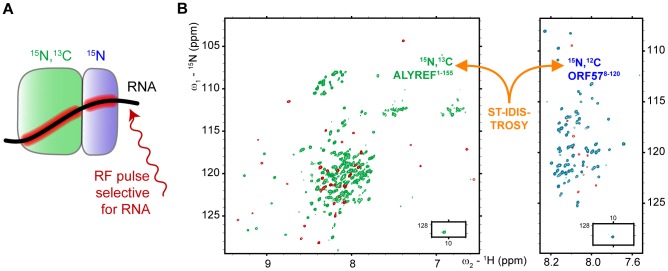
Obtaining site-specific information on RNA binding to protein-protein complex.(A) Scheme illustrating the principle of the ST-IDIS-TROSY method proposed here. RNA is added to a differentially labeled pair of interacting proteins, and selective saturation of RNA protons by RF pulses is transferred through space to the adjacent amides within both proteins in the complex. (B) The example of the resultant ST-IDIS-TROSY spectra: signals from amide groups situated within 5 Å of the RNA are selectively weakened (colored red), as detected independently and simultaneously in the spectra of both proteins.